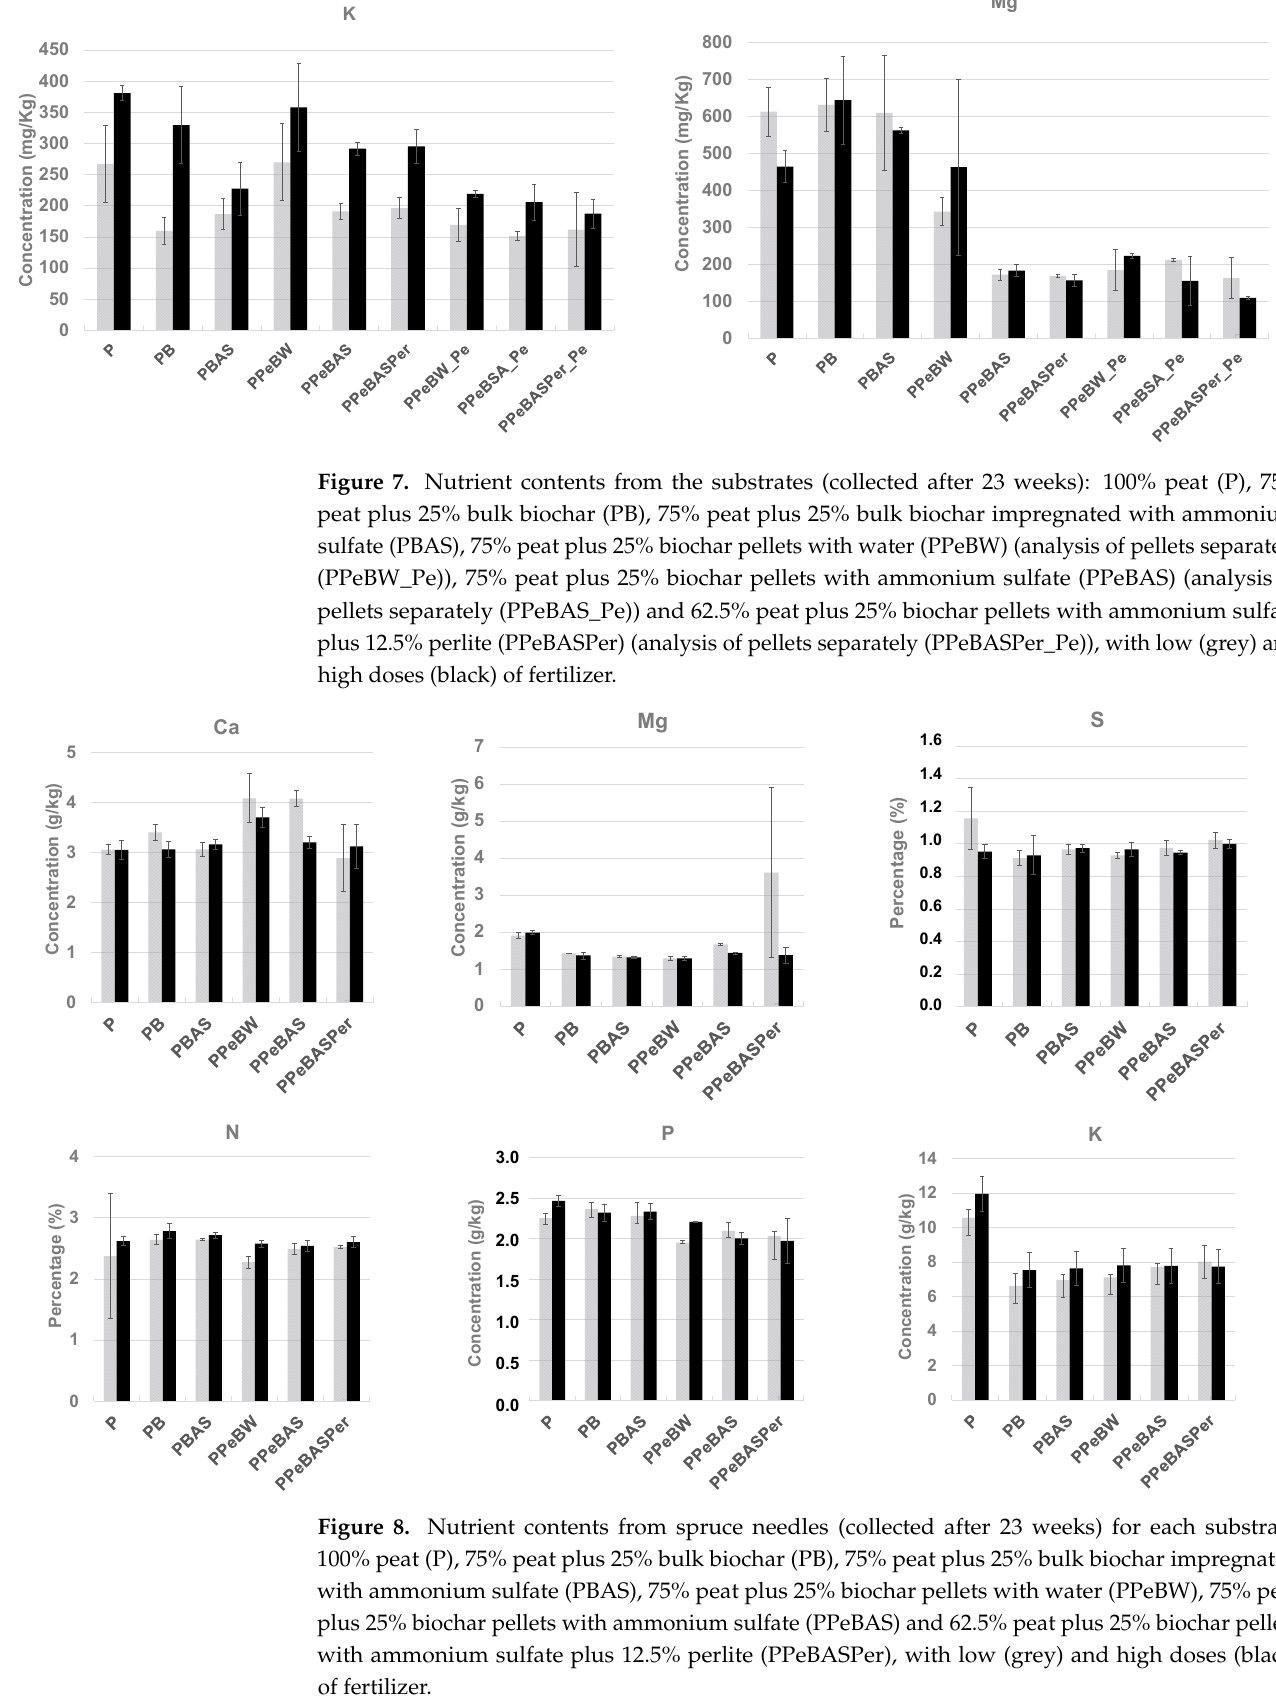
25% biochar pellets with ammonium sulfate (PPeBAS) and 62.5% peat plus 25% biochar pellets with ammonium sulfate plus 12.5% perlite (PPeBASPer), with low (grey) and high doses (black) of ferti- lizer.